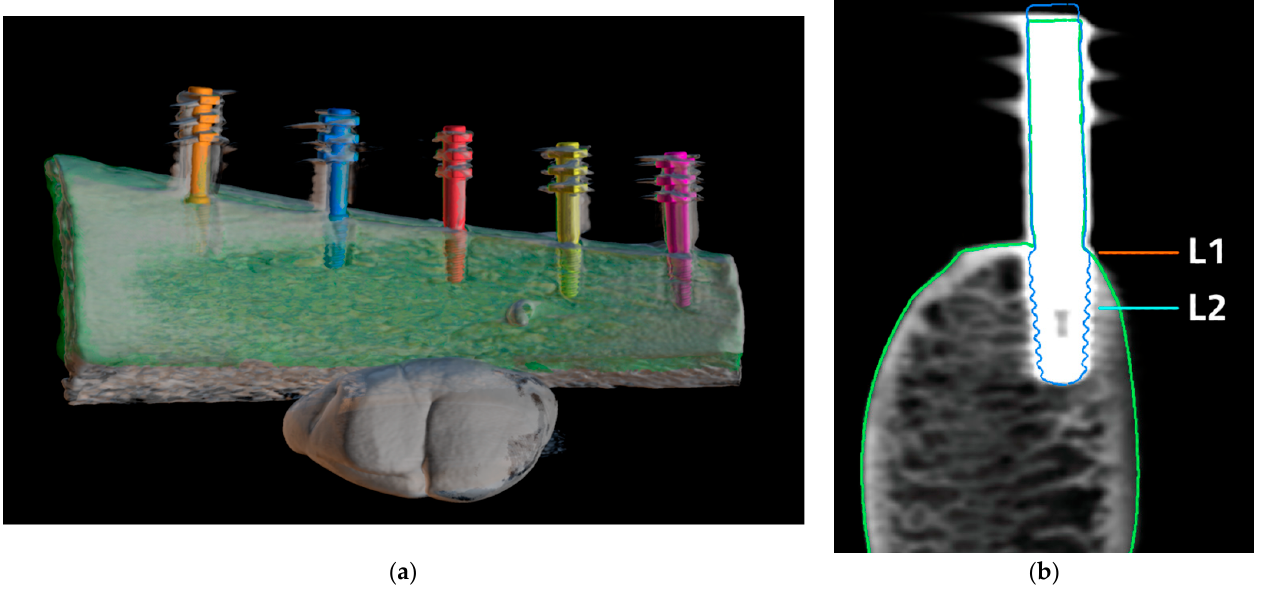
Figure 3. Superimposed STL and DICOM files. ( a ) 3D reconstruction of superimposed DICOM FILES (gray), bone model (green), and implant-with-transfer models (orange, blue, red, yellow, purple); ( b ) Implant cross section, green outline—bone STL model, blue line—implant-with-transfer model. Bone margin measurement levels are marked as L1 (implant neck) and L2 (3.5 mm apically from implant neck).